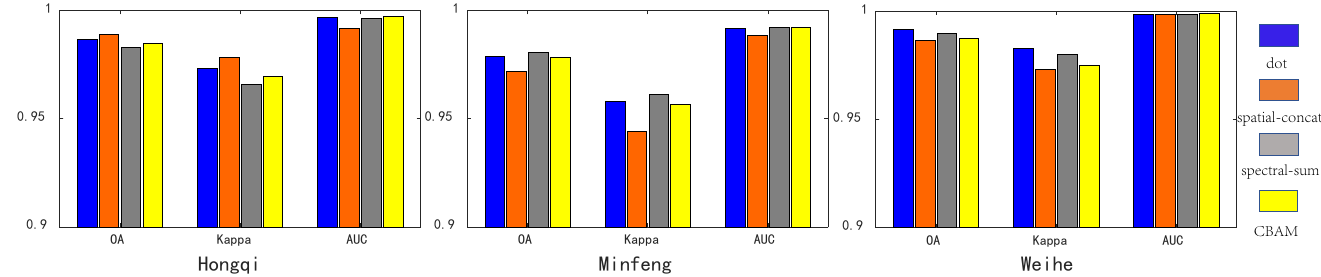
Figure 12. Comparison of different operations on OA, Kappa, and AUC